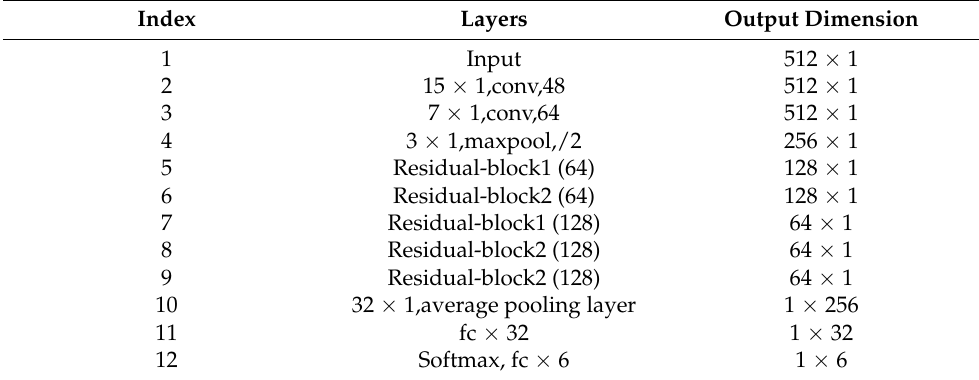
Table 1. Residual network structure parameters r.